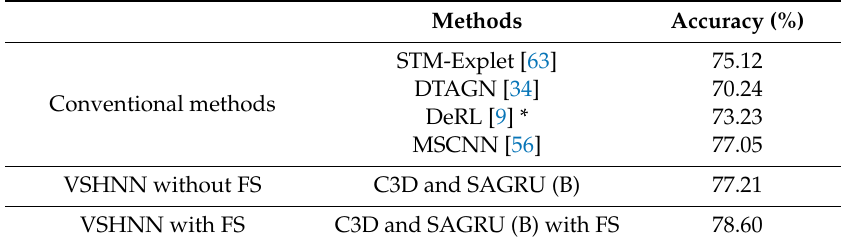
Table 7. Comparison of average accuracy for MMI dataset. The letters in parentheses indicate the type of SARNN. * indicates a method using only image information.